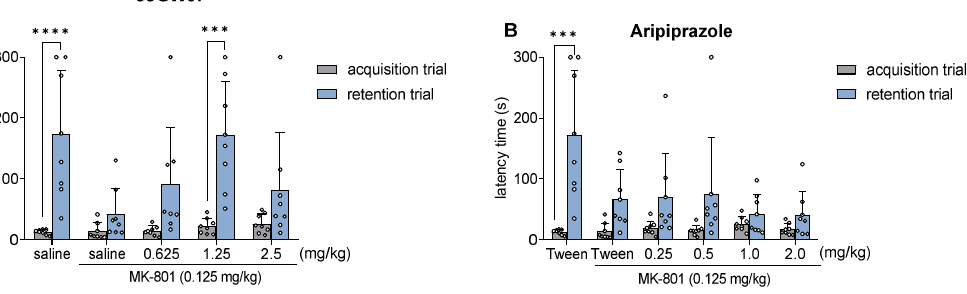
Figure 5. The influence of JJGW07 (Panel ( A )) and aripiprazole (Panel ( B )) on the latency after the MK-801 administration in the step-through passive avoidance task in mice. The experiment consisted of two sessions. In the acquisition trial, mice were placed individually in the light chamber of the apparatus, with the door opening after 30 s. When the animal crossed to the dark chamber, the door closed and the animal was punished with an electric shock (0.8 mA, 2 s). JJGW07 and aripiprazole were administered intraperitoneally ( ip ) 30 min before the test, while MK-801 (0.125 mg/kg) was administered ip 15 min before the start of the experiment to induce the memory impairments. The control group received an ip 0.9% NaCl/1% Tween solution in two injections or 0.9% NaCl/1% Tween solution and MK-801 (0.125 mg/kg; ip ). On the second day of the test, the mice were placed again in a bright chamber and the latency was measured for a maximum of 300 s (without the electrical impulse). Values are expressed as means ± SD; n = 8 mice per group. Statistical analysis: two-way ANOVA with repeated measures (Bonferroni post hoc); *** p < 0.001, **** p < 0.0001 vs. acquisition trial. Aripiprazole at the doses of 0.25–2.0 mg/kg did not influence the latency time in the effect (F(1,42) = 34.47, p < 0.0001), a significant influence of the compound (F(5,42) = 3.353, p = 0.012), and an interaction (F(5,42) = 4.204, p = 0.003) (Figure